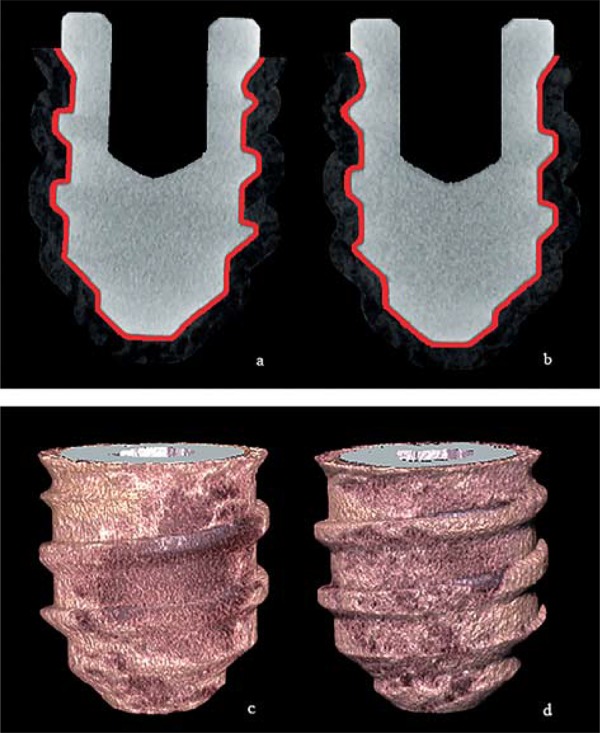
 a and b) Representative coronal slice of Placebo (a) and Micronutrients groups (b), respectively. Red band represents the excluded layer around the implant (5 voxels). BIC parameter was calculated in addition to these 5 layers of voxels. Around the red band, note the assessed bone layer (20 voxels); c and d) Representative tridimensional images of assessed bone volume reconstructed using a computer program of Placebo (c) and Micronutrients groups (d)